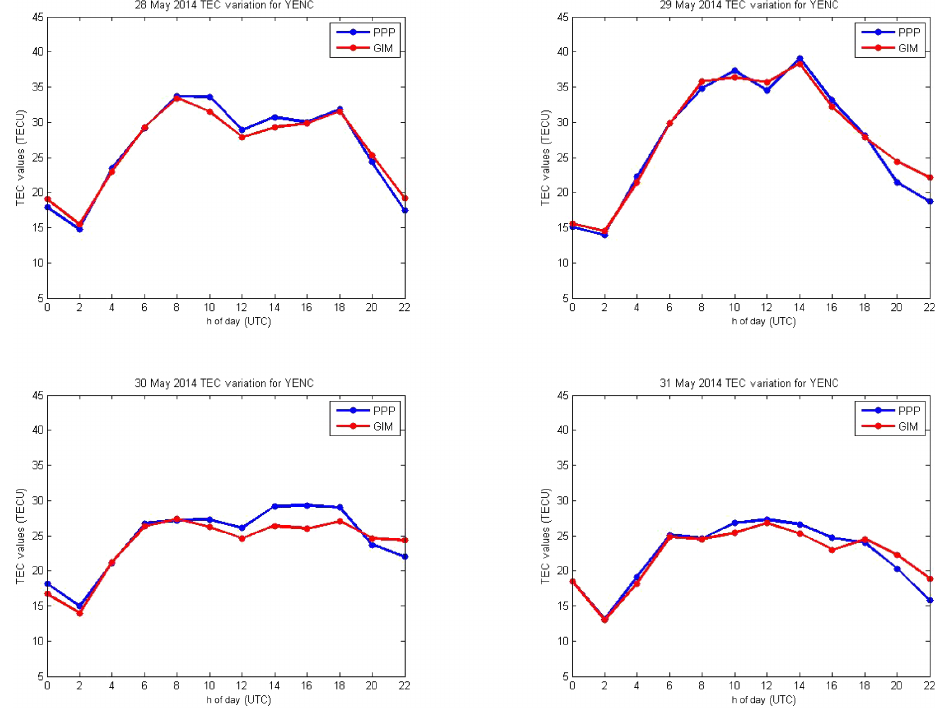
Figure 7. Representation of PPP and GIM-TEC values for the YENC station. Table 3. CANA station 2h resolution average TEC data.